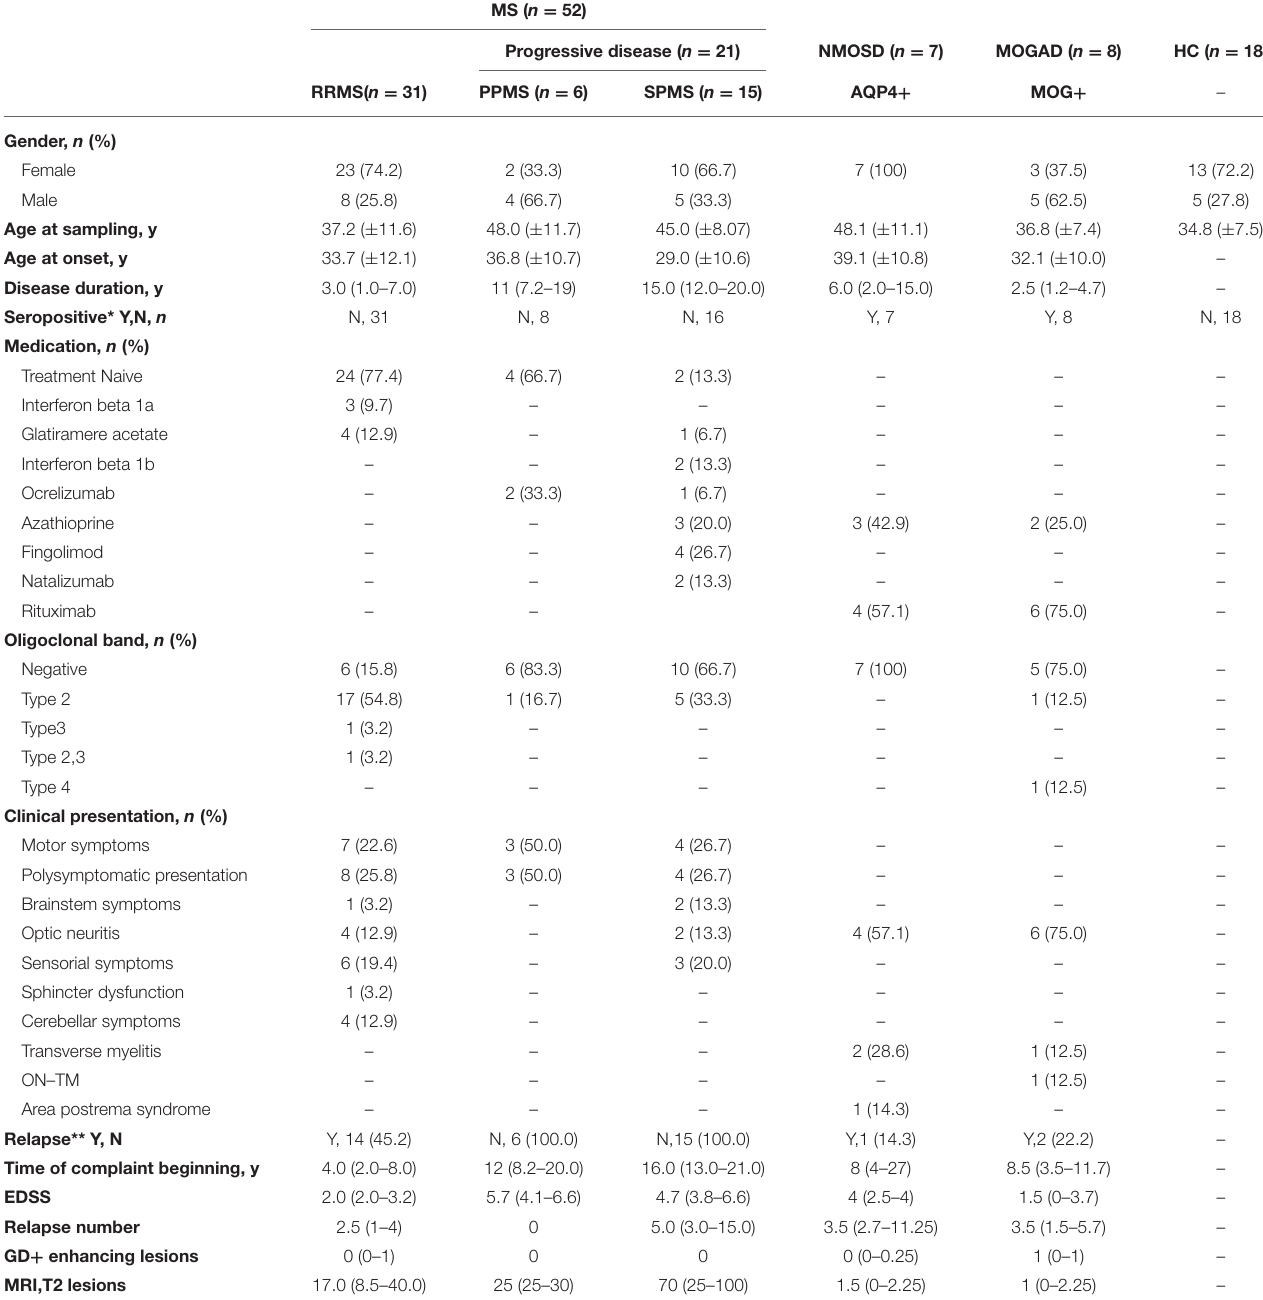
TABLE 1 | Demographic and clinical characteristics of the